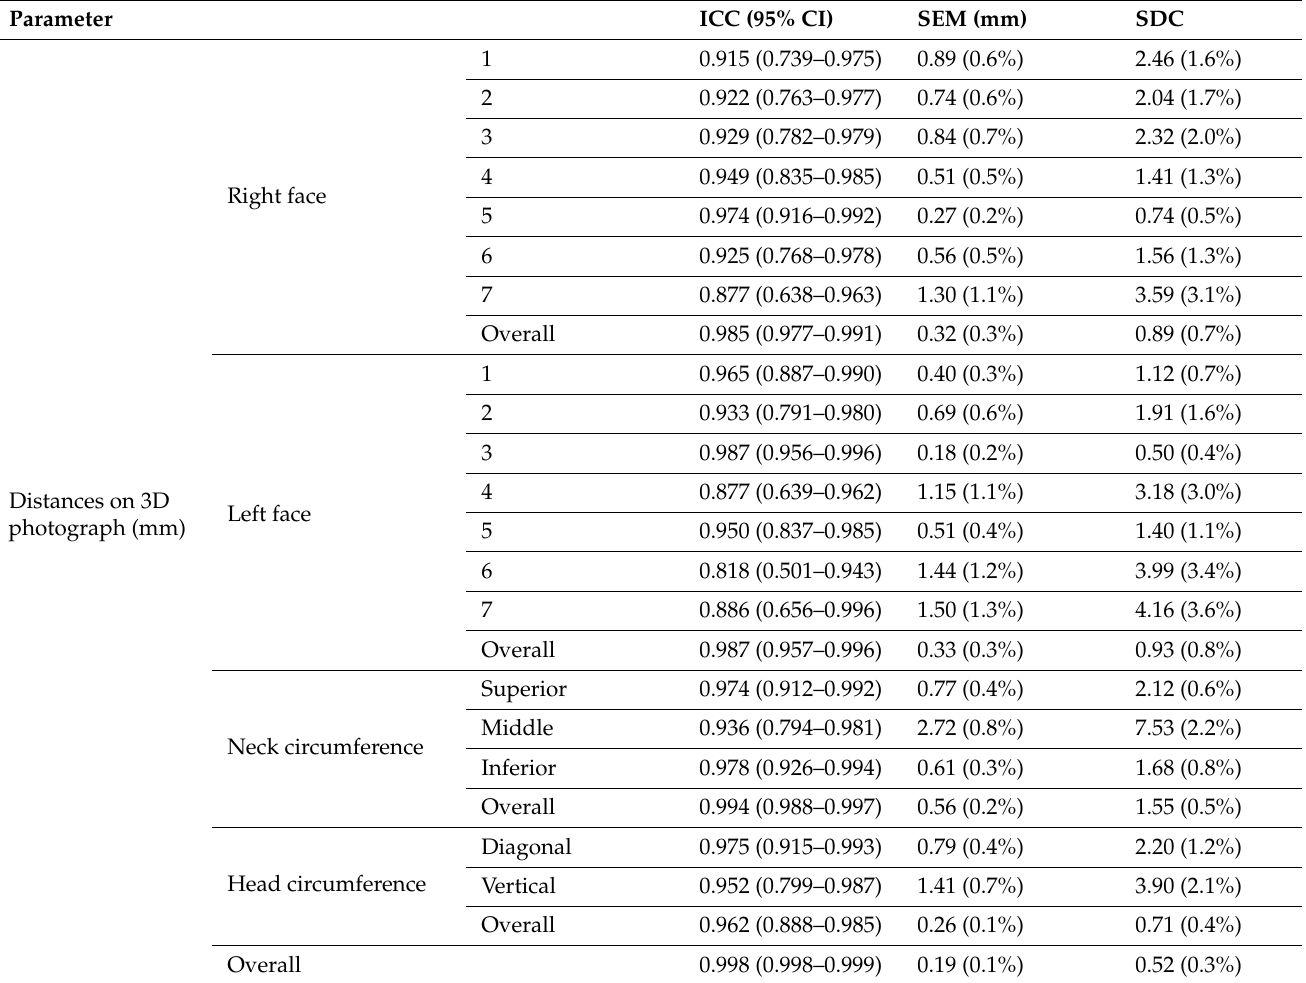
Table 4. Intraclass correlation coefficients (ICCs) with 95% confidence intervals (CI), standard error of measurement (SEM), and smallest detectable change (SDC) for test-retest measurements at 3D